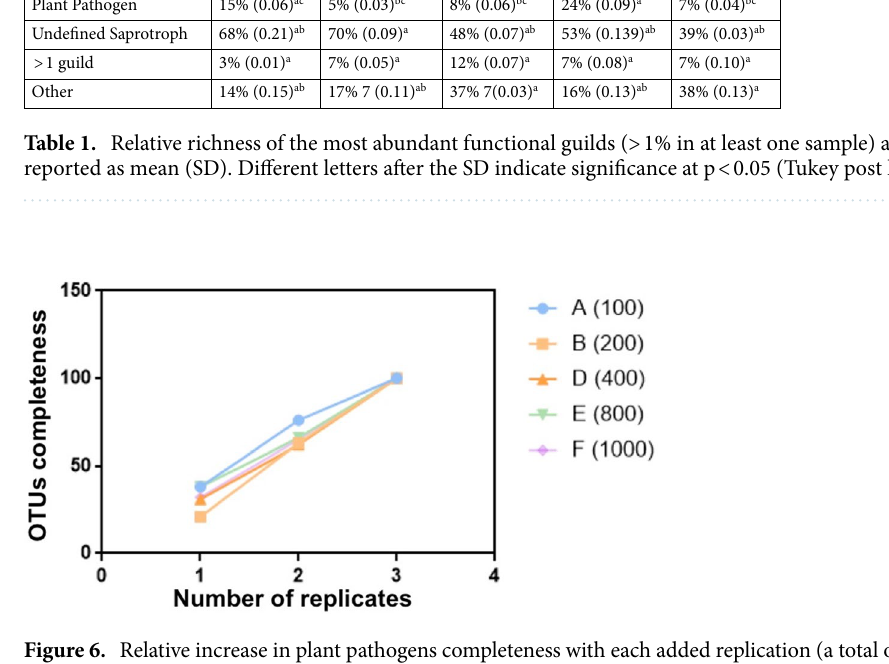
Figure 6. Relative increase in plant pathogens completeness with each added replication (a total of three) for different amounts of seed samples [A = 100 seeds ( ), B = 200 seeds ( ), D = 600 seeds ( ), E = 800 seeds ( ) and F = 1000 seeds (